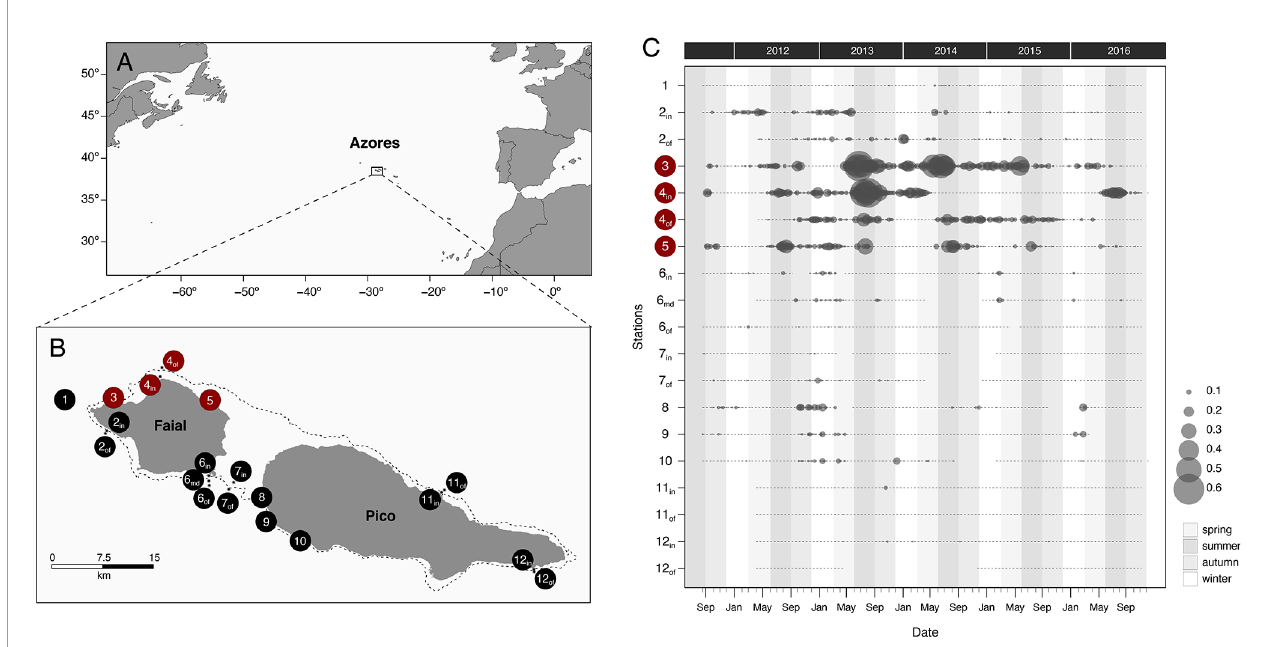
FIGURE 1 | (A) The Azores in the north Atlantic. (B) Locations of the acoustic receivers around Faial and Pico islands with the nursery sites highlighted in red, the dashed line marking the edge of the island shelf. (C) Inter-annual pattern of weekly presence of acoustically tagged juvenile smooth hammerhead shark ( Sphyrna zygaena ) at receivers around Faial and Pico; gray circles represent the total detections averaged per shark at each station, vertical shaded bars represent seasons, and interruptions in the horizontal dotted lines mark the inactivity periods of a